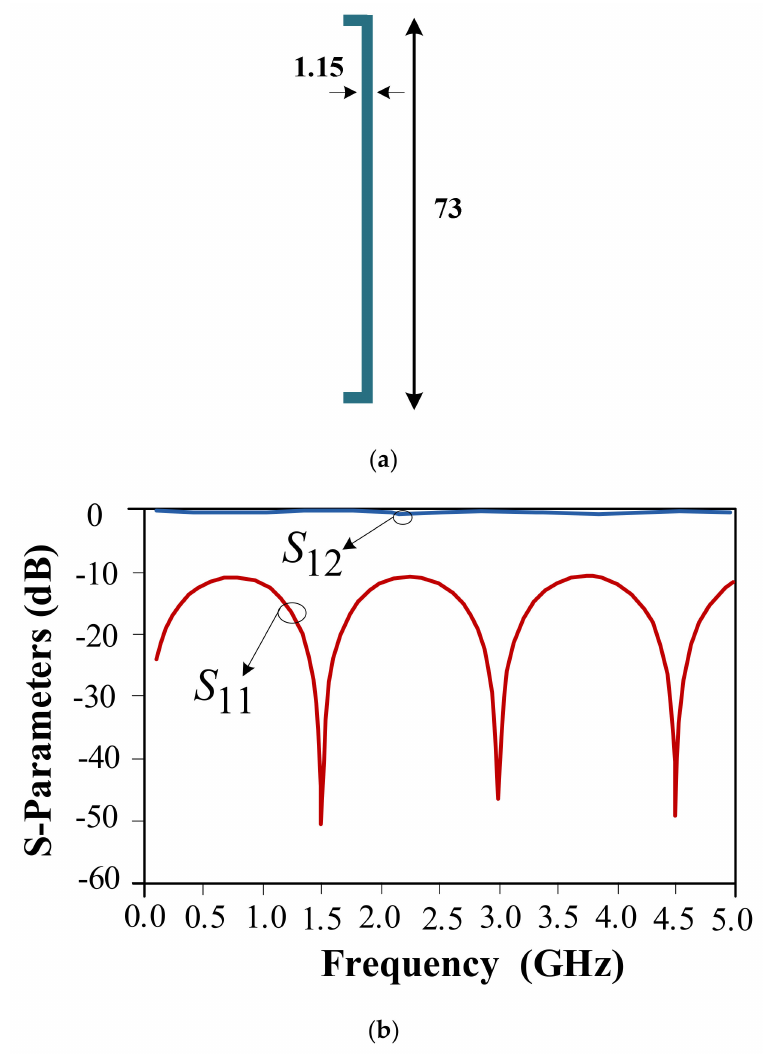
Figure 3. Vertical λ /4 branch of 50 Ω impedance at 750 MHz; ( a ) layout with dimensions in millime- ters, and ( b ) the simulation of the S 11 and S 12 magnitudes in